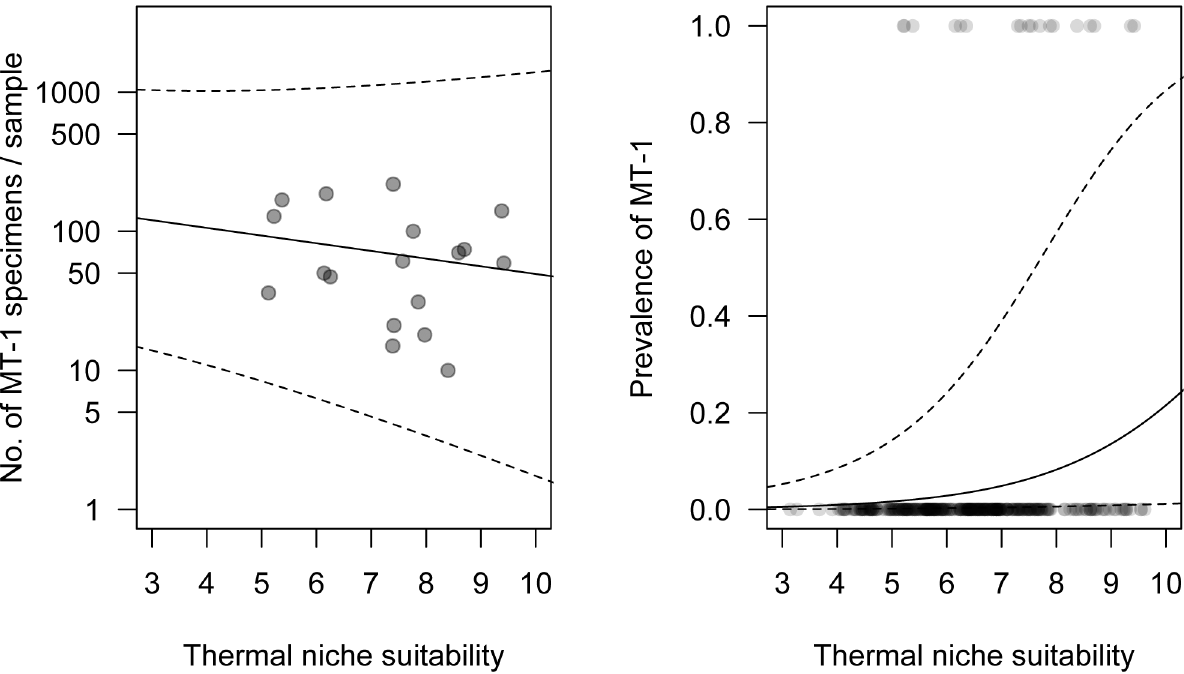
Fig 6. The hurdle model relating thermal niche suitability (TNS) to abundance (A) and prevalence (B) of Aceria tosichella lineage MT-1. Solid lines are predictions from the model and dashed lines represent standard error bands. Abundance of MT-1 in a sample was not dependent on TNS, while prevalence was.